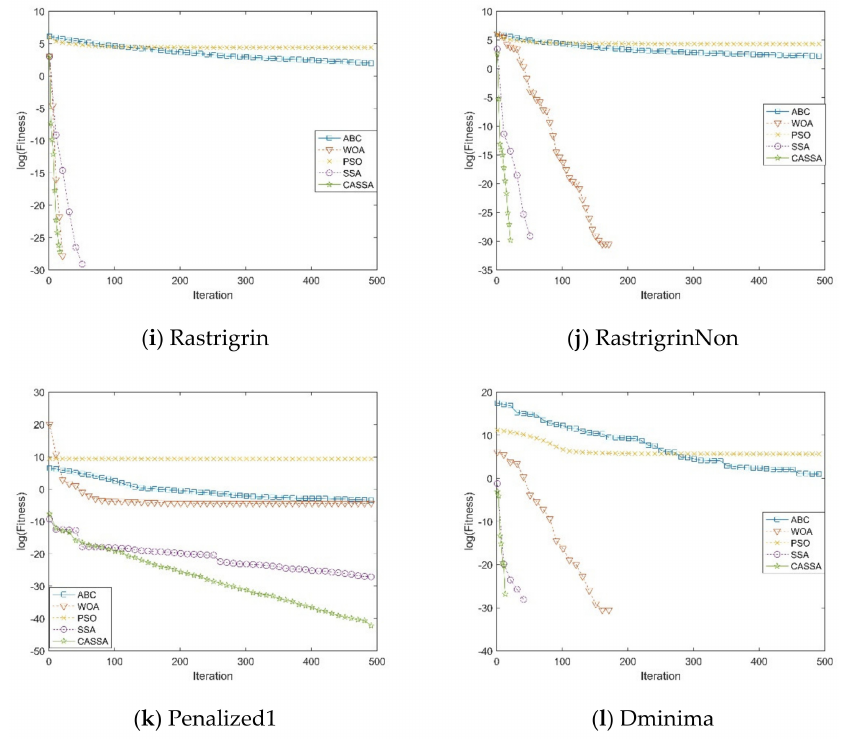
Figure 5. Convergence curve of five algorithms on twelve benchmarks functions. Table 4. Experimental results of benchmark